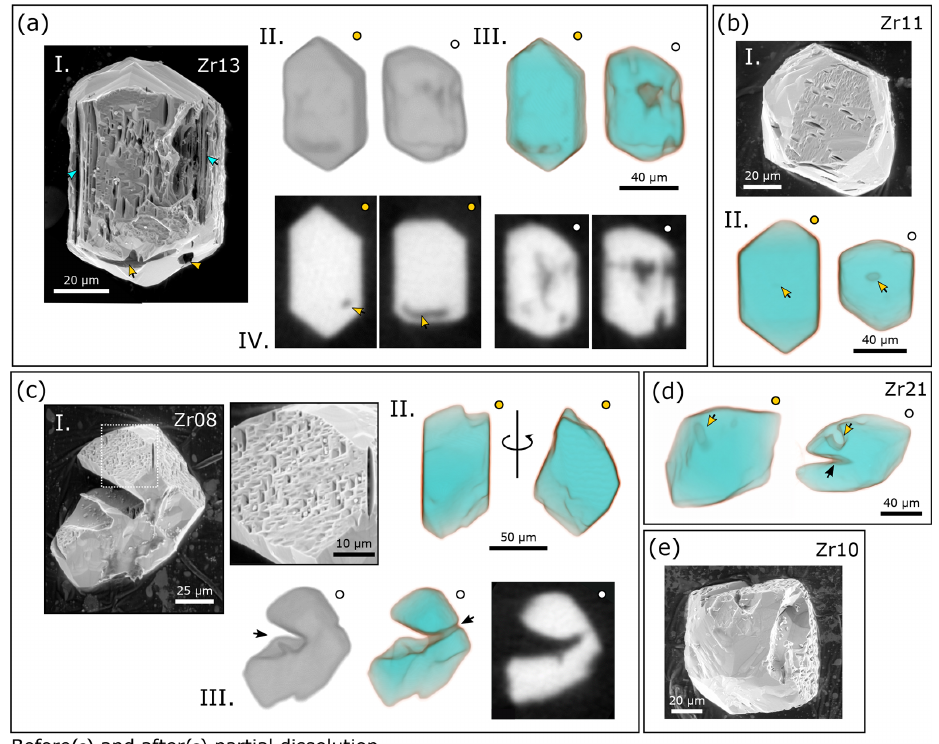
Figure 15. SE and µCT images of KR18-04 grains pre- and post-chemical abrasion at 210 ◦ C for 12h. (a) Subpanel (I) shows an SE image of Zr13, showing dissolved inclusions (yellow arrows) and the removal of oscillatory zones (teal arrows). (II) Opaque 3D rendering of µCT data. (III) Semi-transparent 3D rendering of µCT data. (IV) Representative 2D µCT image slices indicating that a significant amount of zircon material was dissolved from the grain’s interior. Yellow arrows correlate with those in (I). (b) Subpanel (I) shows an SE image of Zr11, showing deep etch pits on (100) with the long axes oriented parallel to the crystal’s c axis. Etch pits are absent from other crystal faces. (II) Semi-transparent 3D rendering of µCT data showing a dissolved inclusion. (c) Subpanel (I) shows SE images of Zr08. The high- magnification image shows closely spaced and overlapping prismatic etch pits that form a sponge-like texture. (II) Semi-transparent 3D rendering of µCT data acquired before partial dissolution. (III) Opaque and Semi-transparent µCT 3D renderings and a representative 2D µ CT image slice of the sample after partial dissolution. Black arrows highlight acid paths into the grain interior. (d) Semi-transparent 3D rendering of µCT data for Zr21. Yellow arrows mark an inclusion that dissolved. The black arrow highlights the acid path that inexplicably cut into the grain interior. (e) SE image of Zr10 with deep prismatic etch pits present on some grain surfaces but not